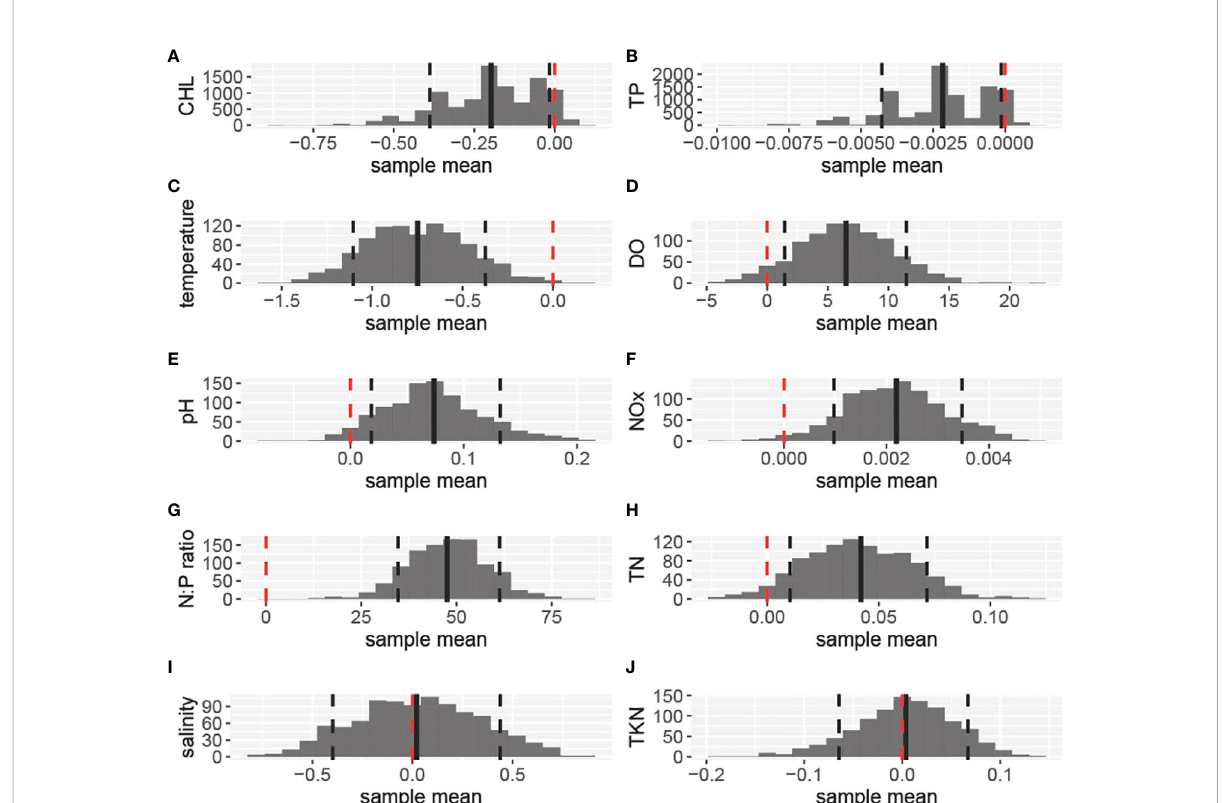
FIGURE 6 Histograms depicting the frequency of bootstrapped mean differences for each of the water quality and nutrient parameters: (A) . depicting chlorophyll-a; (B) . Total Phosphorus (TP); (C) . temperature; (D) . Dissolved Oxygen (DO); (E) . pH units; (F) . Nitrates and Nitrates (NOx); (G) . N:P ratio; (H) . Total Nitrogen (TN); (I) . Salinity in ppt; and (J) . Total Kjeldahl Nitrogen (TKN). The differences were calculated by subtracting the coral absence group values from the coral presence group values (i.e., coral presence- coral absence). For each parameter, the mean value of the differences is depicted with a vertical solid black line, while the con fi dence intervals (0.10, 0.90) are depicted with dashed lines. The red lines correspond to the zero value and are used for signi fi cance